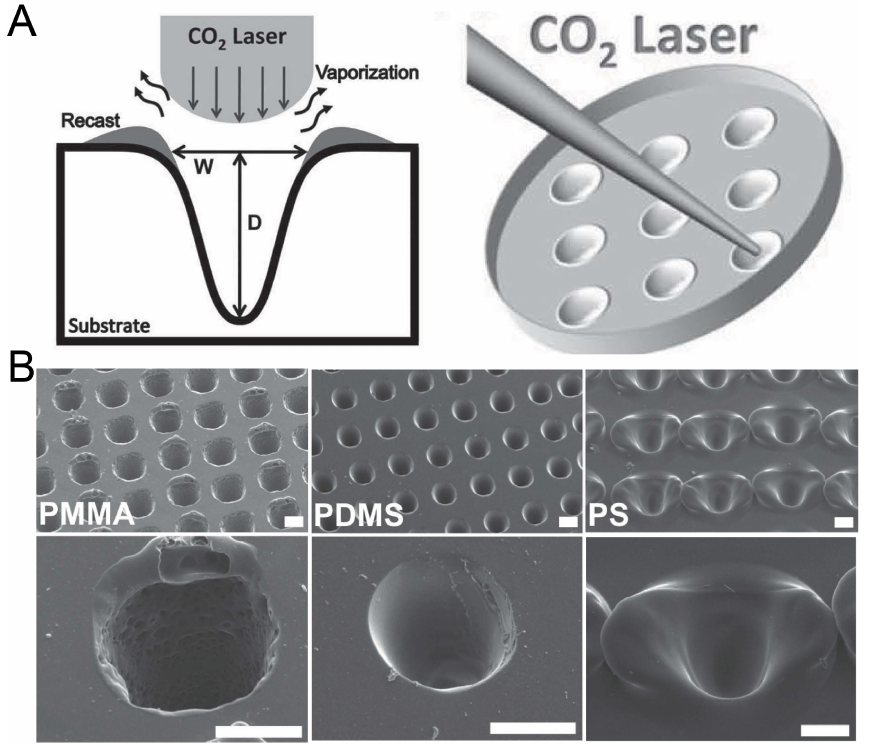
Figure 9. Fabrication of concave microwells by laser ablation [74]. ( A ) The schematic of the working principle of laser ablation for microwell fabrication. ( B ) The SEM pictures of concave microwells fabricated on PMMA, PDMS, and PS substrates by laser ablation. Scale bars: 100 µm. Reprinted (adapted) from [74]. Copyright (2013) with permission from John Wiley and